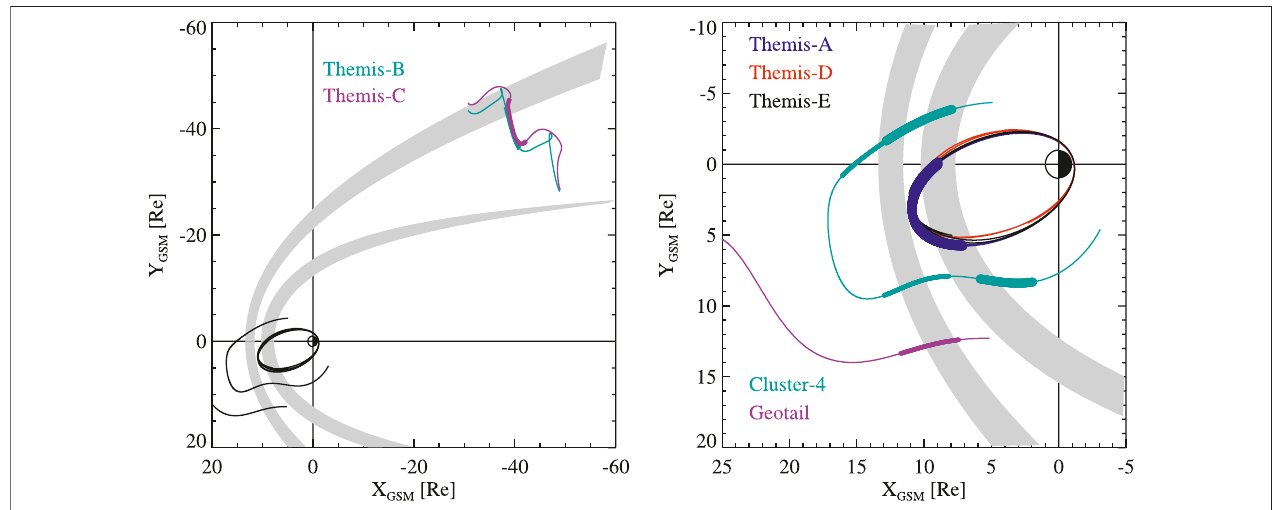
FIGURE 2 | Spacecraft trajectories in the GSM X − Y plane during Feb 18 – 20, 2014. The grey shadings show a range of magnetopause and bow shock locations based on the range of solar wind conditions during the period. The thickest line segments show periods when the SCWeb locator places the trajectory within 2 R E from the magetopause, the medium thick segments show periods when the trajectory is within 2 R E from the bow shock position.